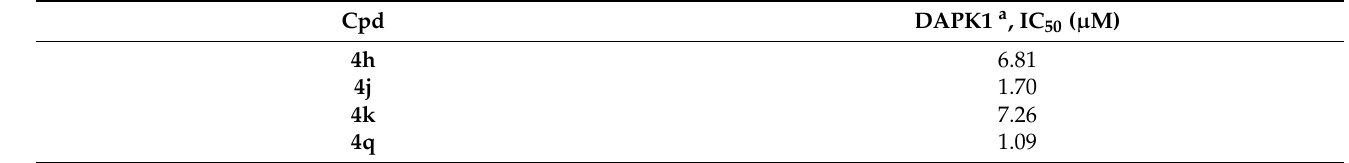
Table 4. IC 50 values of compounds 4h , 4j , 4k , and 4q against DAPK1 kinase.